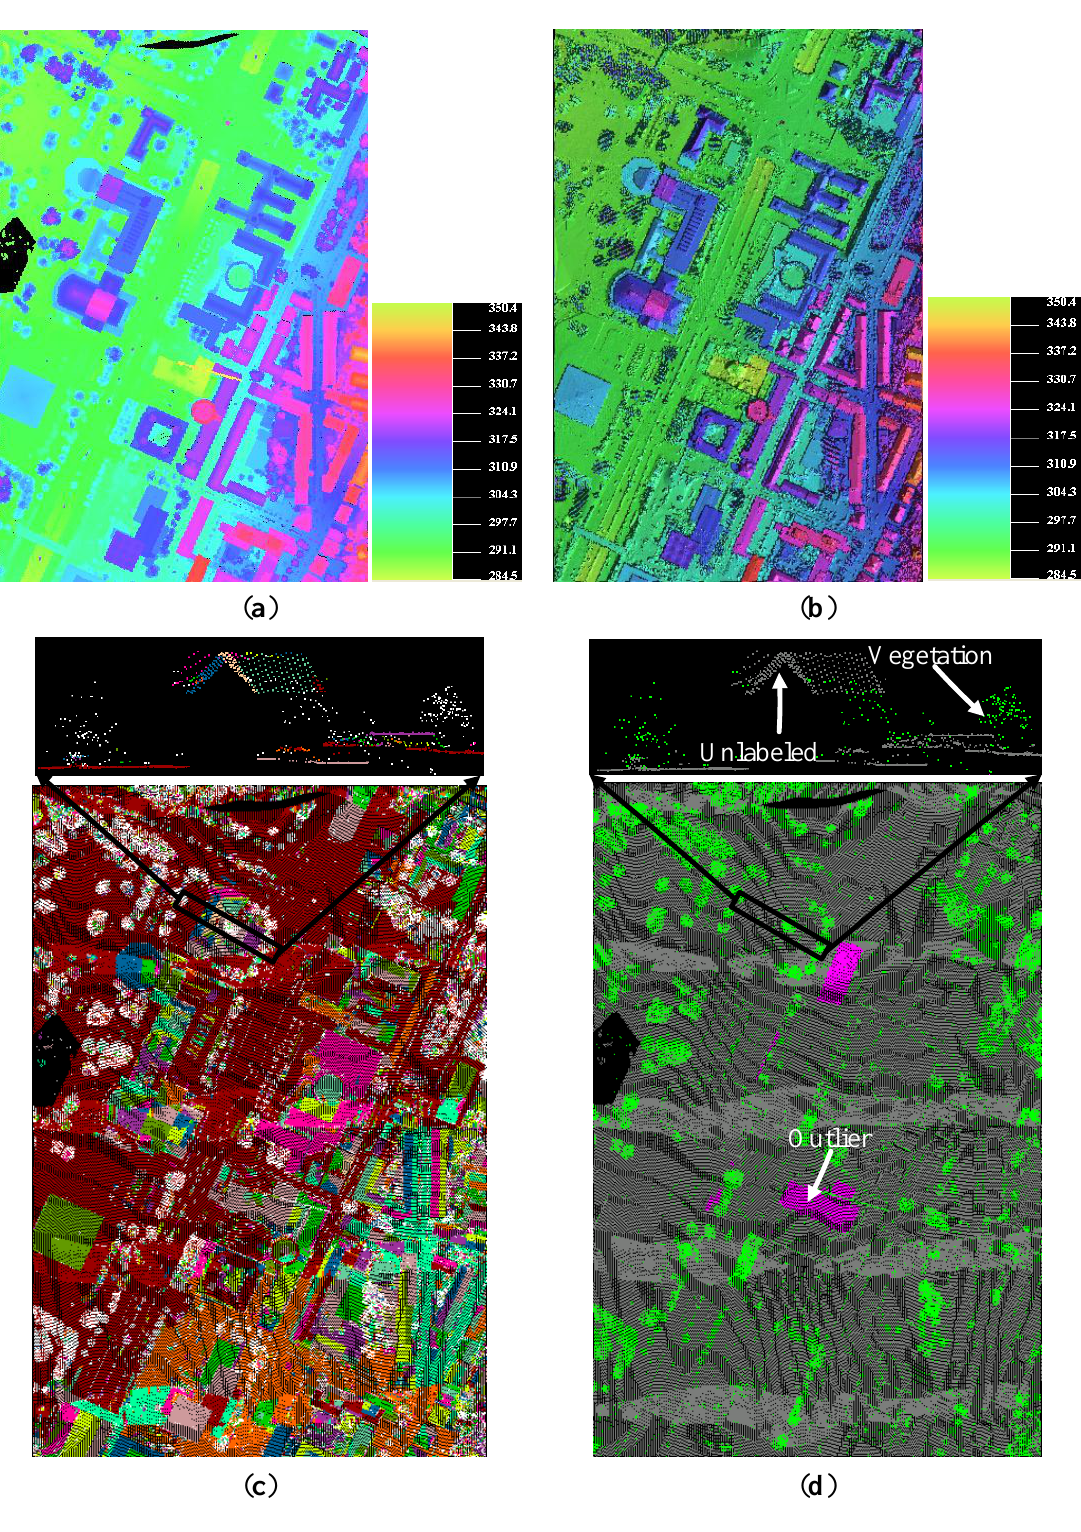
Figure 6. Filtering and results of testing data about CSite2: ( a ) The remaining point cloud after outlier removal; ( b ) TIN of the data in (a); ( c ) Segmentation result of PCSS; ( d ) Detected vegetation measurements by multiple echoes analysis of segments; ( e ) Detected ground seed segments colored by the labeling number; ( f ) Detected ground measurements by SBF method; ( g ) Detected ground measurements by the classic PTD method; ( h ) Differences between (f) and